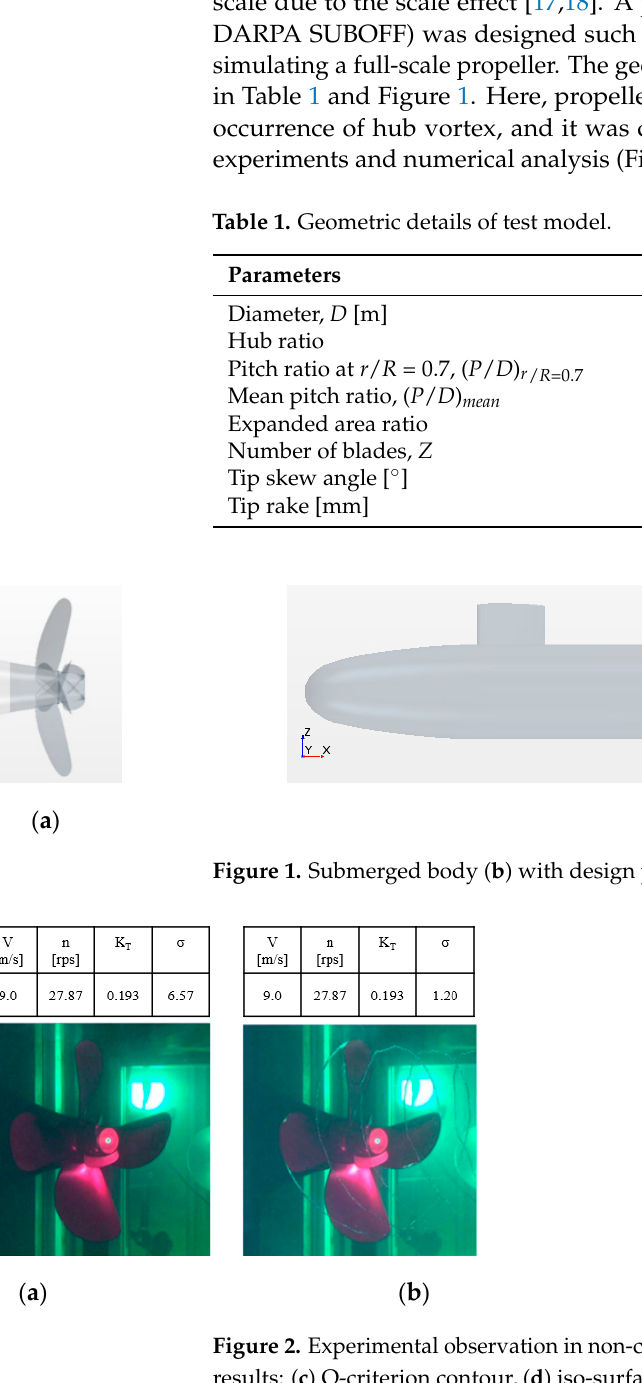
Table 1. Geometric details of test model.